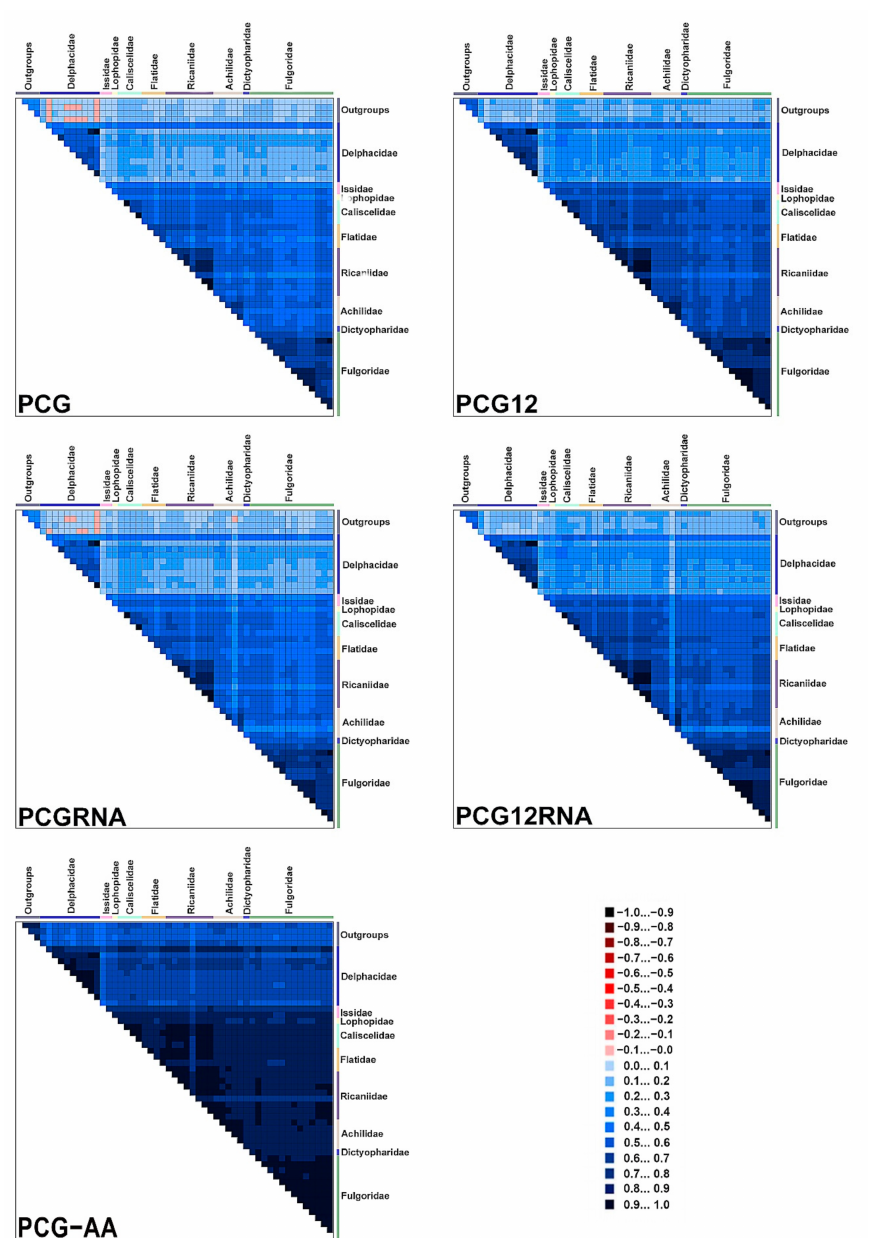
Figure 7. Heterogeneous sequence divergence for five different data sets with 53 taxa. Each colored square represents the pairwise Aliscore values. The scores range from − 1, indicating a great difference in sequence composition (red coloring), to +1, indicating similarity to other sequence composition (blue coloring). The taxon names of different families are represented by color-coded boxes, listed on top and on the right side of the